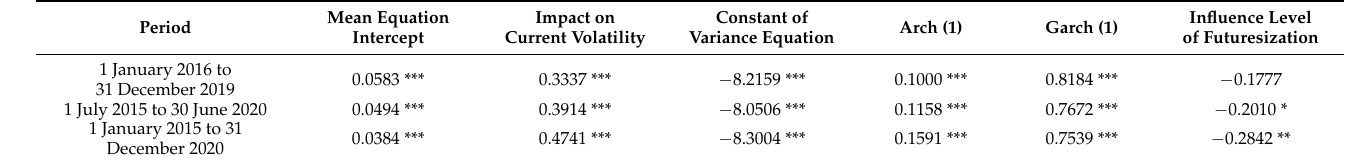
Table 4. GARCH model